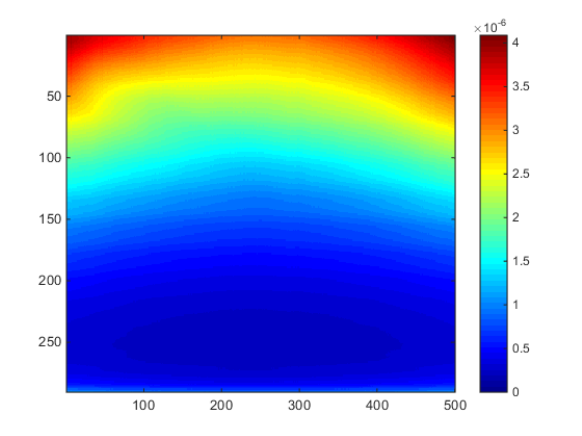
Figure 1: Radiometric calibration coefficients for the camera used in